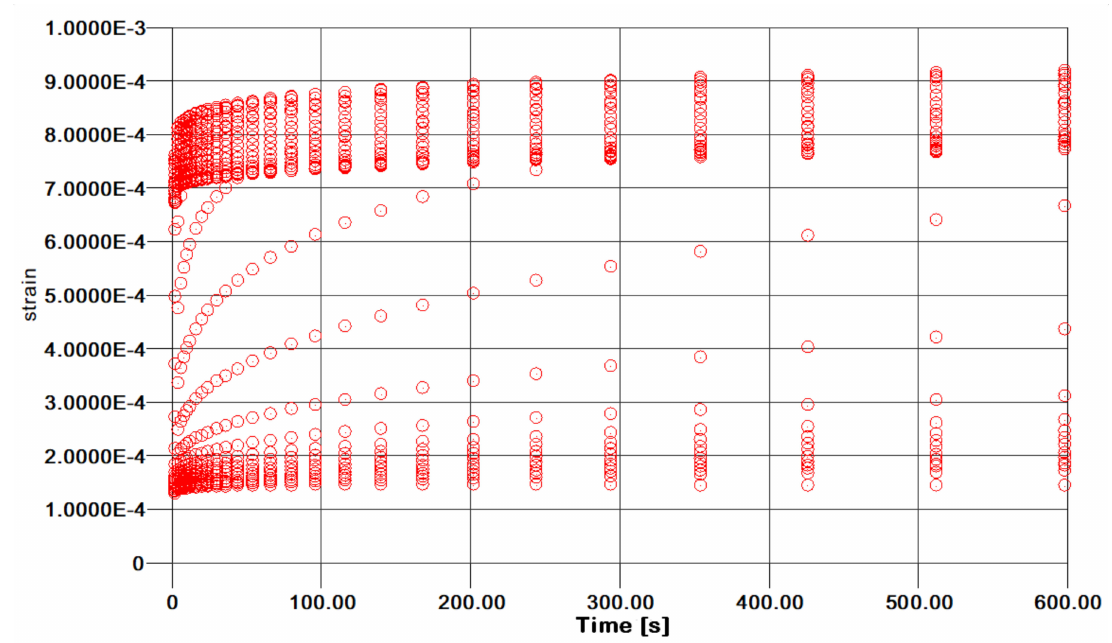
Figure 8. Vectran/aluminum–glass composite hybrid creep TTS curves.